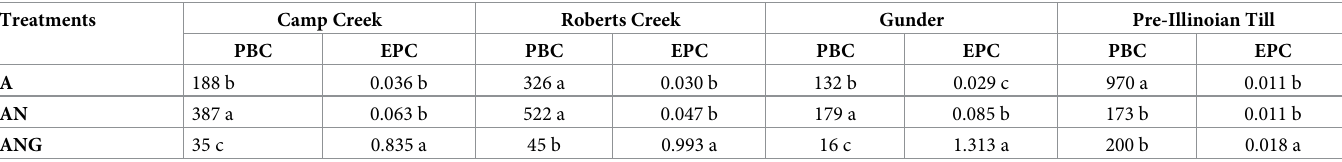
Treatment A is without anaerobic incubation, AN is with anaerobic incubation, ANG is with anaerobic incubation and addition of glucose. Means with the same letter within the same column are not significantly different (least significant difference at α =